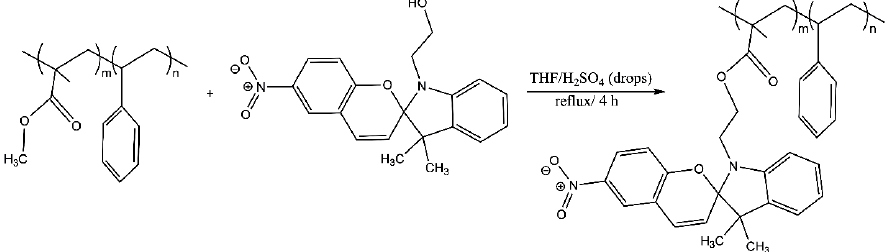
Figure 1. Schematic representation of the (PS- b -PMMA- SP ) block copolymer functionalized with photochromic agent ( SP ).